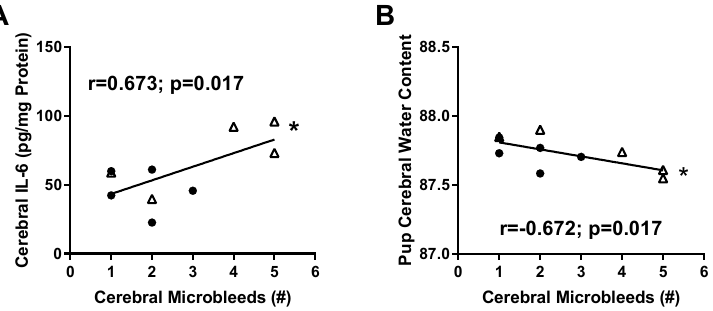
Figure 5. Correlation between number of micro-bleeds and IL-6 levels or brain water content. The number of micro-bleeds is ( A ) positively associated with fetal brain IL-6 levels and ( B ) negatively associated with fetal brain water content. Fetuses from same dam were used for the association analysis. Values for individual rats ( n = 5 fetuses per group) are shown. Relationships between factors were analyzed using the Pearson correlation.